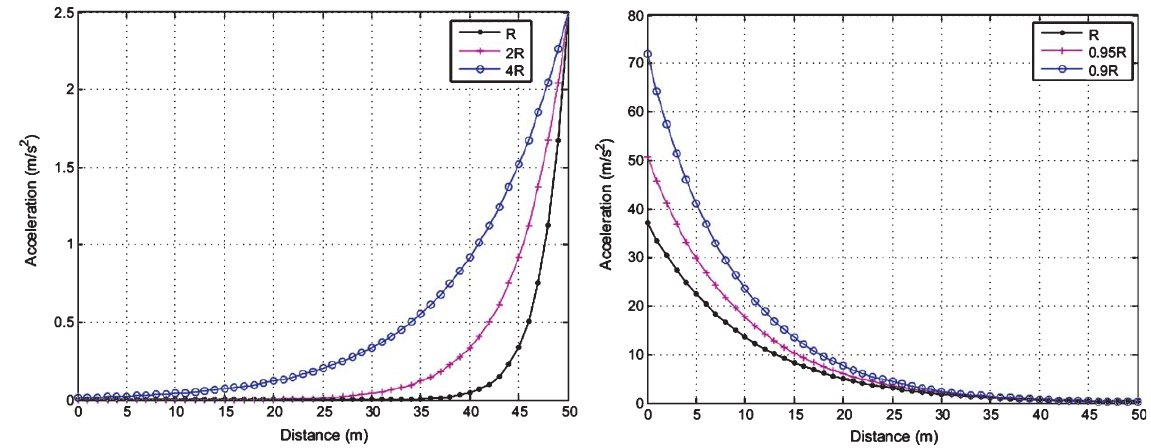
Fig. 7. Exponential acceleration behaviour in 1 D . Left: Attractive potential; Right: Repulsive potential.